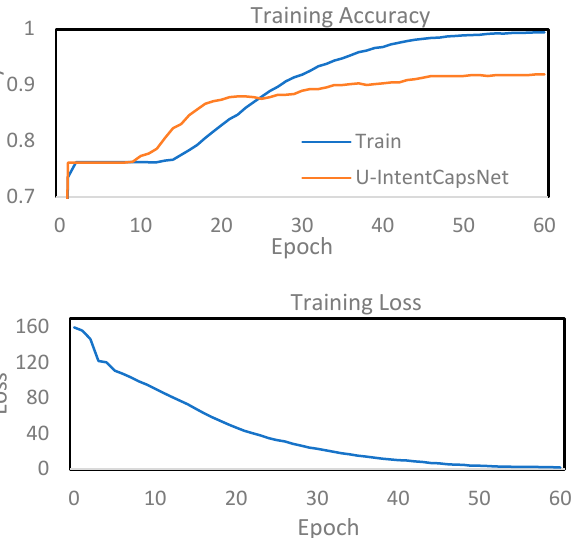
Figure 4. Accuracy and loss curves during training of the proposed U-IntentCapsNet model.